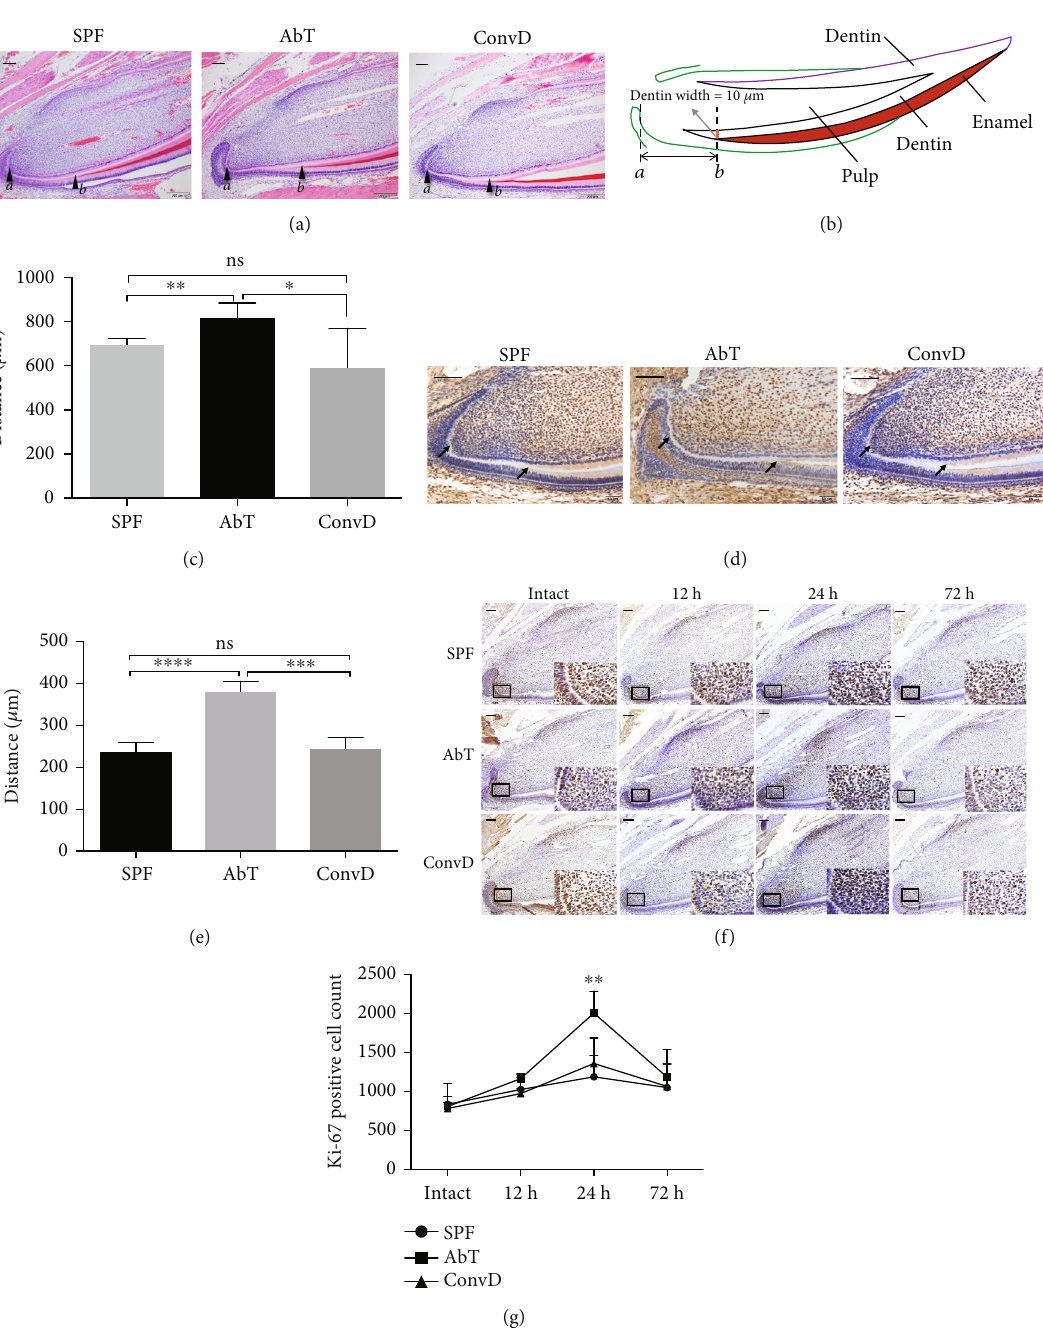
Figure 2: Histological analysis of the apical area and dentin formation of incisors. (a) H&E staining showed the histological structure of the apical area. (b) The distance was measured as the sketch map has shown; point a stands for epithelial invagination, and point b stands for mineralized dentin reaching a width of 10 μ m. (c) The distance between points a and b was calculated, and it showed a longer distance in AbT. (d, e) Immunohistochemical staining of DSPP showed delayed mineralization of dentin in the AbT group. (f, g) Immunohistochemical staining of Ki-67 showed that at 12 hours after injury, Ki-67-positive cells began to accelerate (the second panel), and acceleration of Ki-67-positive cells reached the peak at 24 hours after injury (the third panel), and at a 72-hour time point, the amount of Ki-67-positive cells descended to almost the same level as the 12-hour time point (the right panel) ( bar = 100 μ m). All experimental data were veri fi ed in at least three independent experiments. Error bars represent the SEM from the mean values. ∗∗∗∗ P < 0 : 0001 ; ∗∗∗ P < 0 : 001 ; ∗∗ P < 0 : 01 ; ∗ P < 0 : 05 . AbT: antibiotic treated; ConvD: conventionalized; SPF: speci fi c